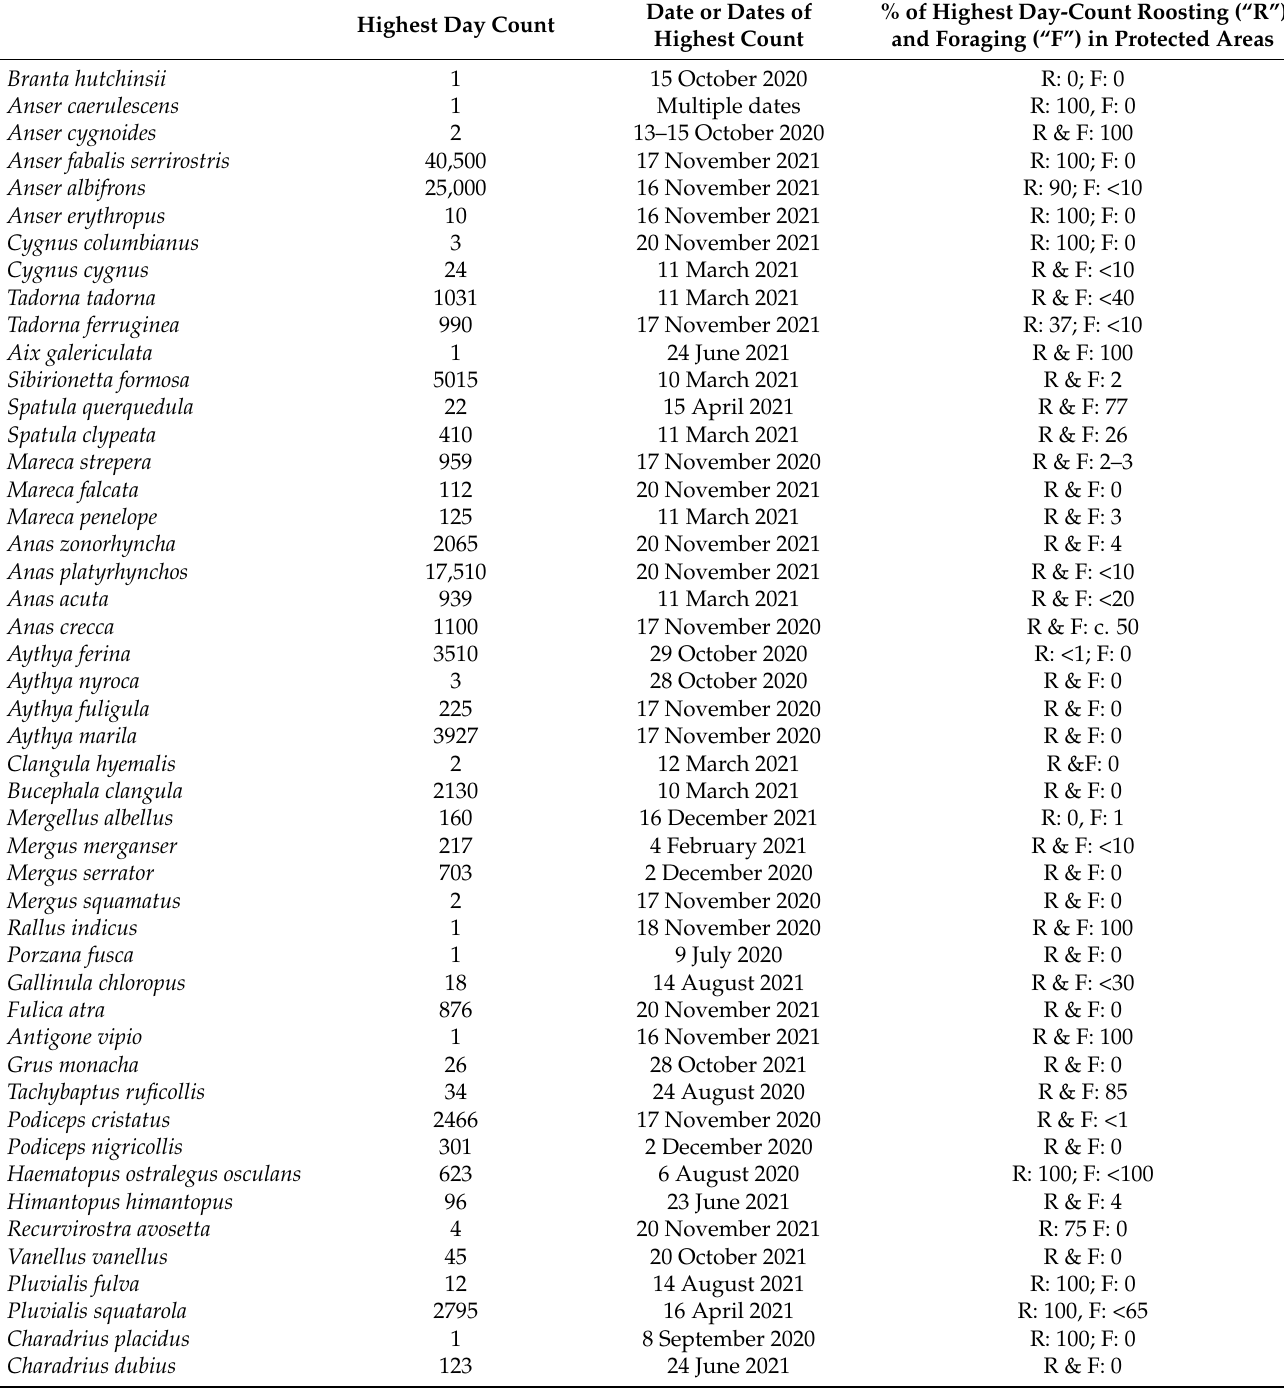
Table A2. List of Waterbird species recorded during the research in coastal Hwaseong (June 2020- November 2021), with their highest day-count or day counts; and the percentage of that total which roosted (“R”) and Foraged (“F”) within the Tidal Flat Wetland Protected Area and the Proposed Freshwater Wetland Protected Area (combined, “Protected Areas”). * indicates two days of counts used: one with the highest day-count, the second with counts of the presumed same individuals in a different part of the wetland complex. ? Indicates the absence of data for the focal subset and species. Highest Day Count Highest